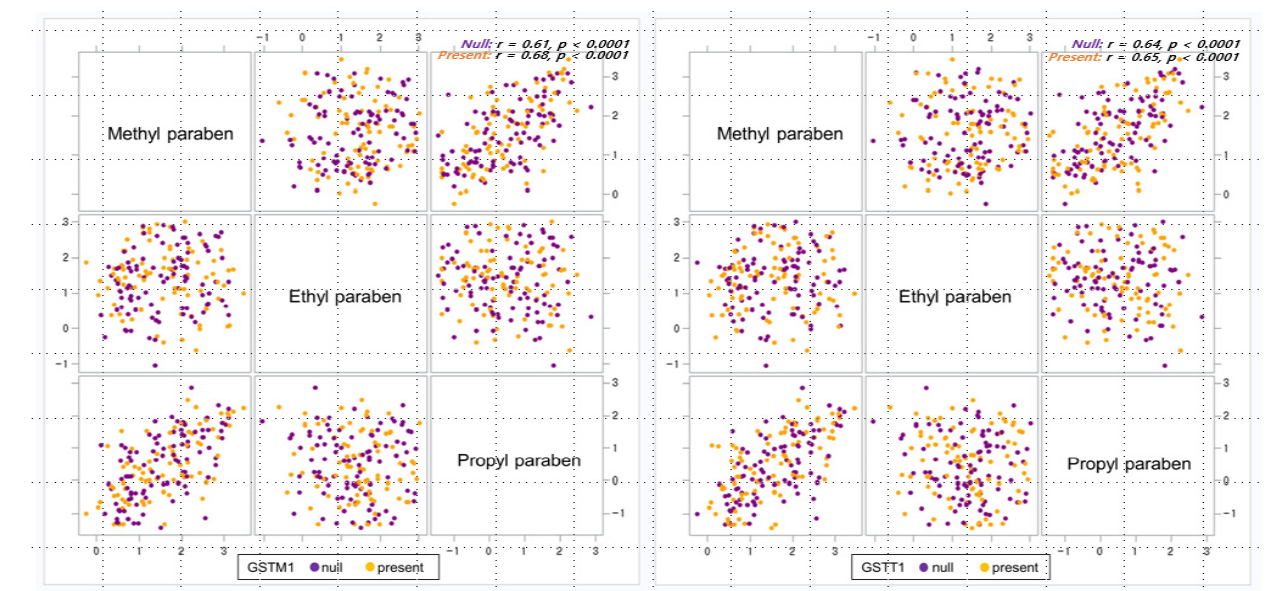
Figure 1. The relationship between parabens according to GSTM1 and GSTT1 genotype. Table 3. Concentrations of parabens in maternal blood according to participant characteristics.